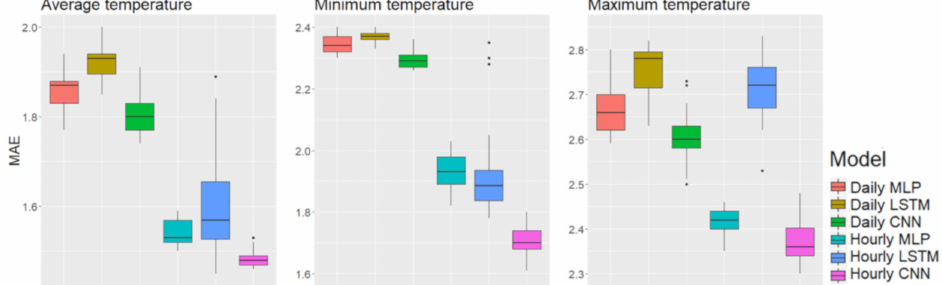
Figure 5. Box plots of the best performance among the di ff erent input lengths in the mountainous area, Daegwalleong.